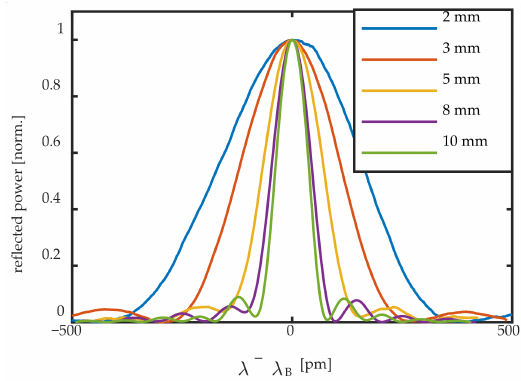
Figure 3. Normalized reflection spectrum of the five FBG sensors with increasing grating